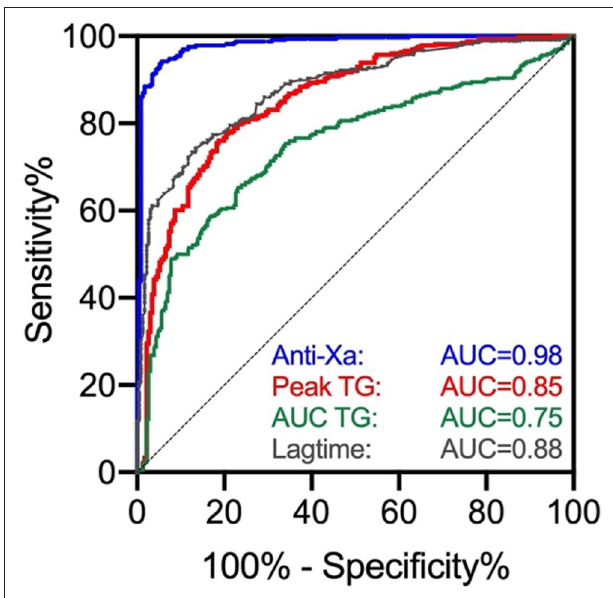
FIGURE 4 | Receiver operating characteristics (ROC) curve of thrombin generation results and anti-Xa measurements for clinically relevant concentrations of rivaroxaban, apixaban, and edoxaban (50 µ g L − 1 ). AUC was 0.98 for anti-Xa measurements, 0.85 for peak thrombin generation, 0.75 for AUC, and 0.88 for lag